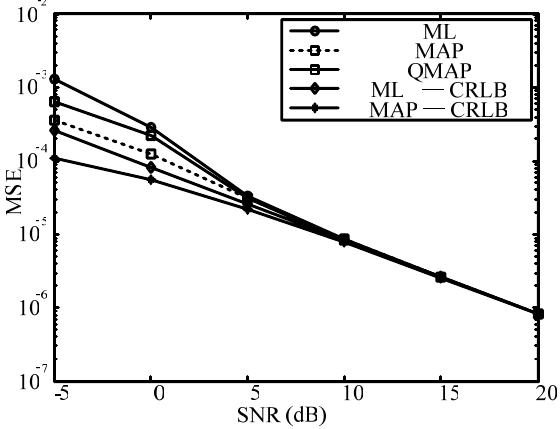
Fig.6.Performance comparison between optimum and